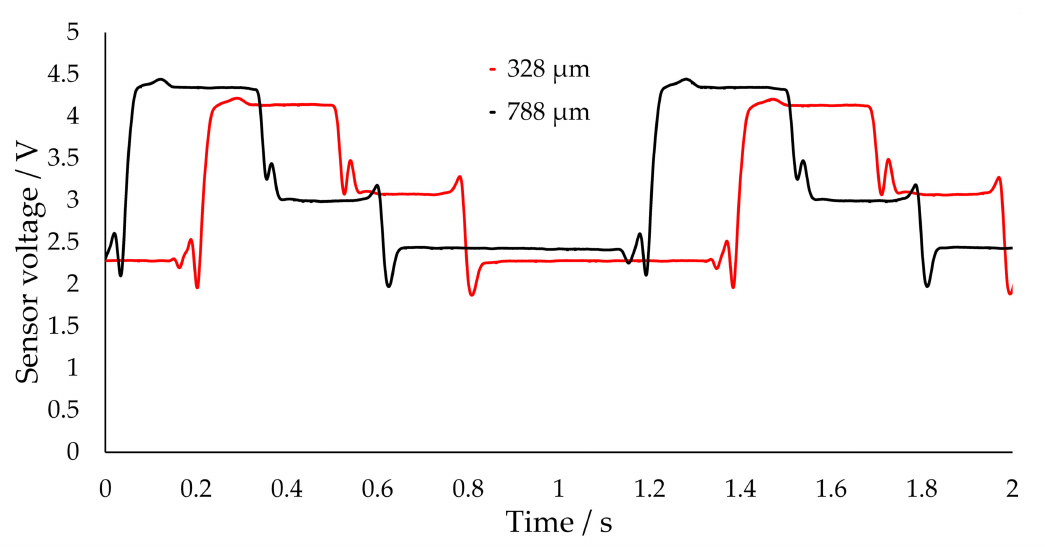
Figure 8. Measured voltages for two positions of the capillary relative to the phototransistor. The height is the distance between the lowest capillary position in the transmissive sensor and its actual position. Shown are positions with approximatively the same distance to the centered position. Plateaus: nitrogen (~2.3–2.5 V), 1-hexanol (~3.0–3.2 V), water (~4.2–4.4 V). The signals where shifted with respect to